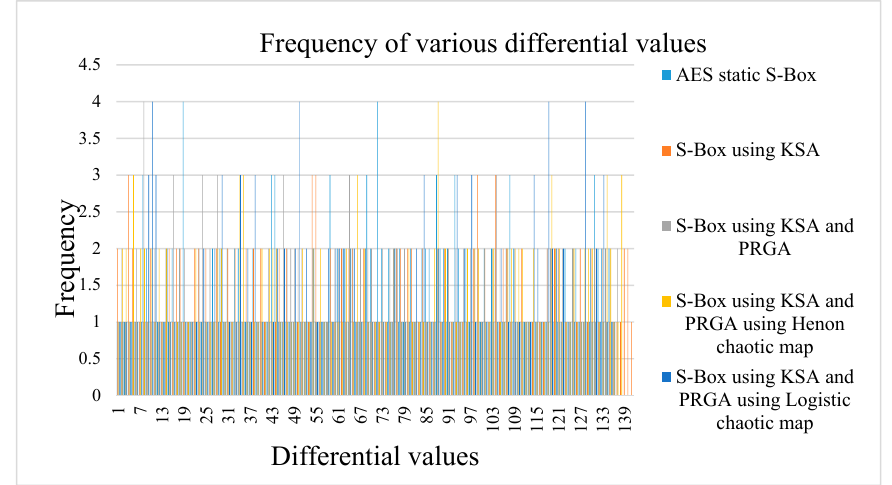
Figure 9. Analysis of the frequency versus differential values, ∆ Y, for the 5 S-Boxes with the key “0123456789ABCDEF .